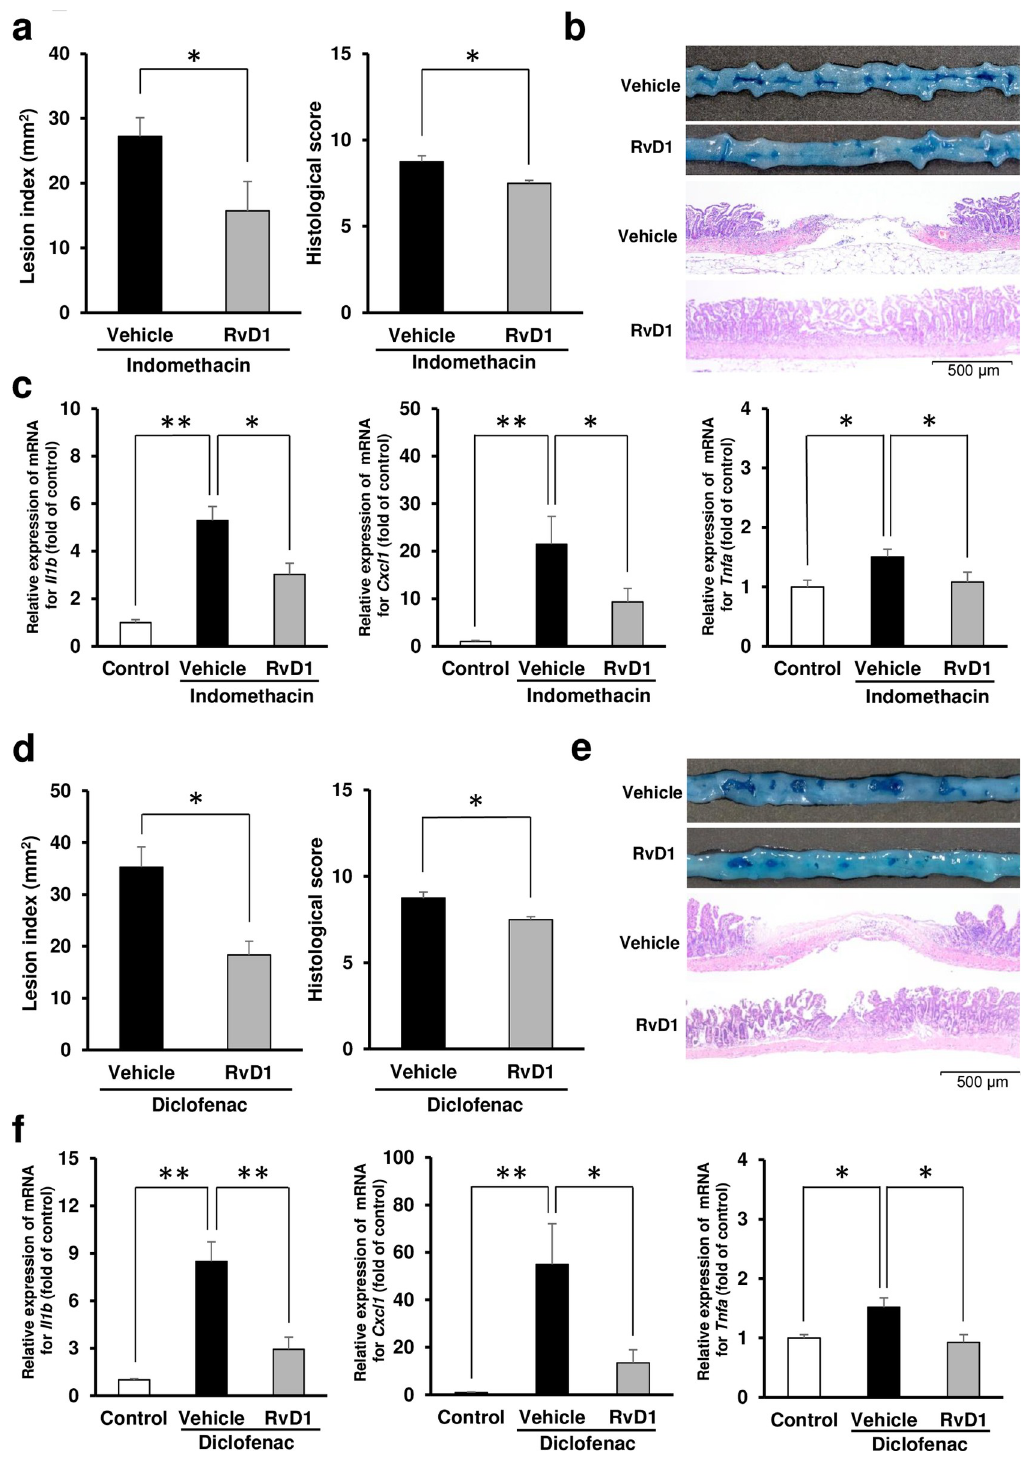
Fig 1. Effects of exogenous resolvin D1 on NSAID-induced small intestinal damage. (a) Lesion index and histological score of the small intestines 24 h after administration of indomethacin (10 mg/kg BW) in mice pretreated with vehicle or resolvin D1 (RvD1: 10 μ g/kg BW). N = 7–8. (b) Representative macroscopic and microscopic images of small intestine 24 h after administration of indomethacin in mice pre-administered with RvD1 (10 μ g/kg BW) or vehicle. Bars in histological images: 500 μ m. (c) The gene expression levels of interleukin-1 β ( Il1b ), CXCL1/keratinocyte chemoattractant ( Cxcl1 ), and tumor